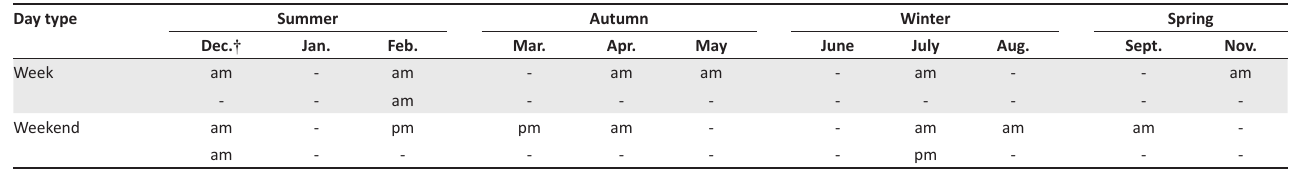
TABLE 2: Summary of aerial surveys conducted each month, grouped seasonally and stratified according to week or weekend day. Day